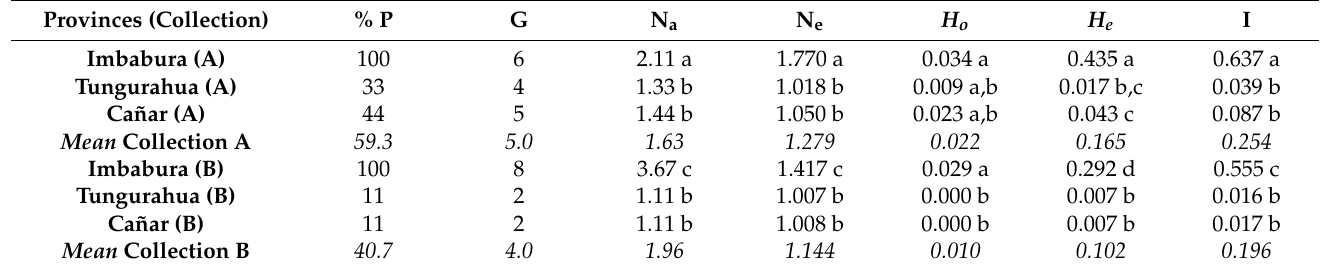
Table 3. Genetic diversity parameters calculated for provinces of Imbabura, Tungurahua, and Cañar in accessions collected between 1981 and 1986 (Collection A) and accessions collected in 2014 and 2015 (Collection B). % P: percentage of polymorphic loci, and G: number of genotypes (allelic combinations). Average values of allele number (N a ), effective number of alleles (N e ), observed heterozygosity ( H o ), expected heterozygosity ( H e ), and Shannon information index (I). For each parameter (data column), different letters indicate significant differences ( p < 0.05).